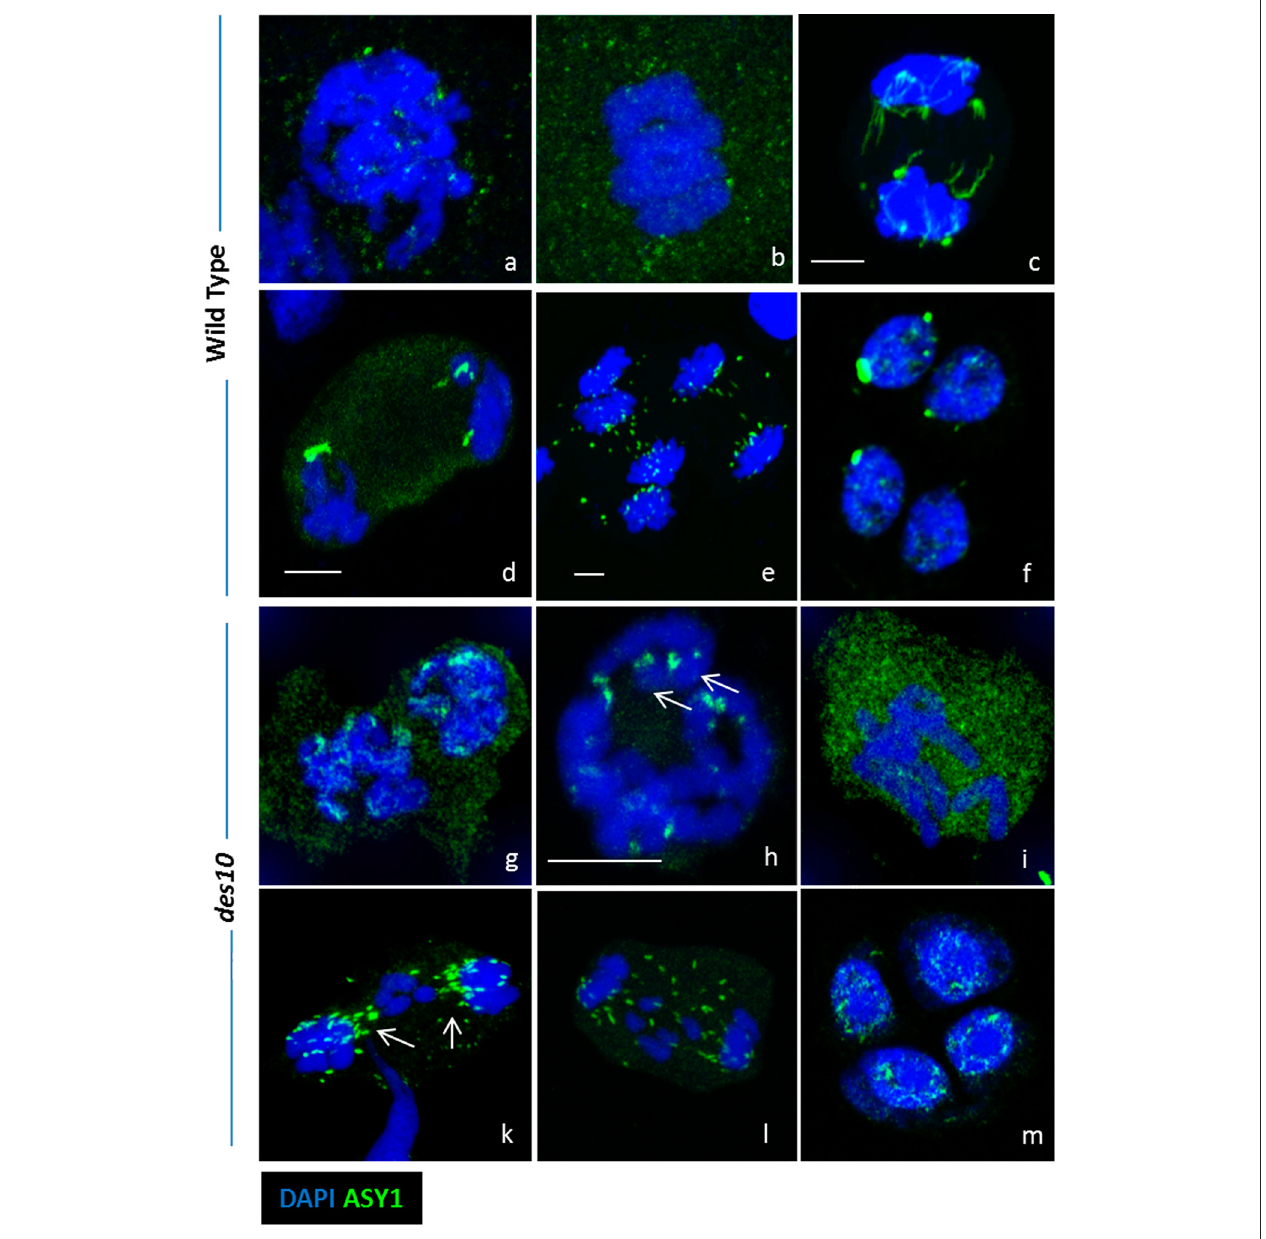
FIGURE 4 | ASY1 re-organization during desynapsis and chromosome segregation. Strong ASY1 signal are detected after prophase I during chromosome segregation in both wild type (a–f) and des10 (g–m) . Discrete ASY1 foci (green) are visible in wild type diplotene (a) . At metaphase I, ASY1 signal does not seems specific and is located in the cytoplasm (b) . During anaphase I, ASY1 signal is either linear (c) or globular (d,e) . Discrete ASY1 signals are also found in tetrads (f) . ASY1 behaves the same in des10 , but the delay in prophase enables more details to be studied. ASY1 signal is present on diplotene chromosomes (g) , and it is possible to visualize the last ASY1 signal near the end of the chromosomes ( h , arrow). During metaphase I, ASY1 is mainly in the cytoplasm (I) but during anaphase I, it is possible to see the ASY1 signal relocated around the lagging chromosomes ( k,l arrows). Discrete ASY1 signal is also found in tetrads (m) . Scale bar 5 µ